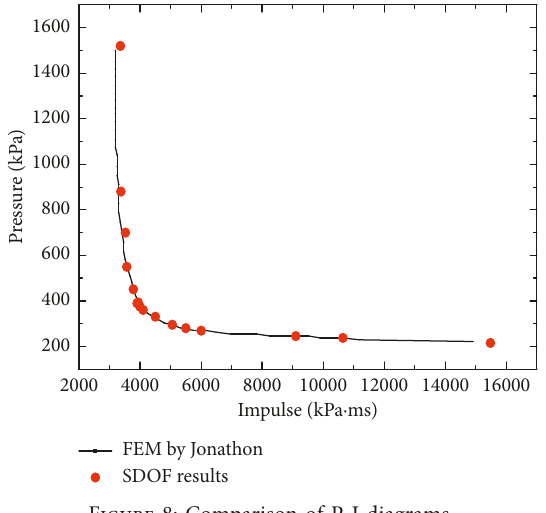
Figure 8: Comparison of P-I diagrams.